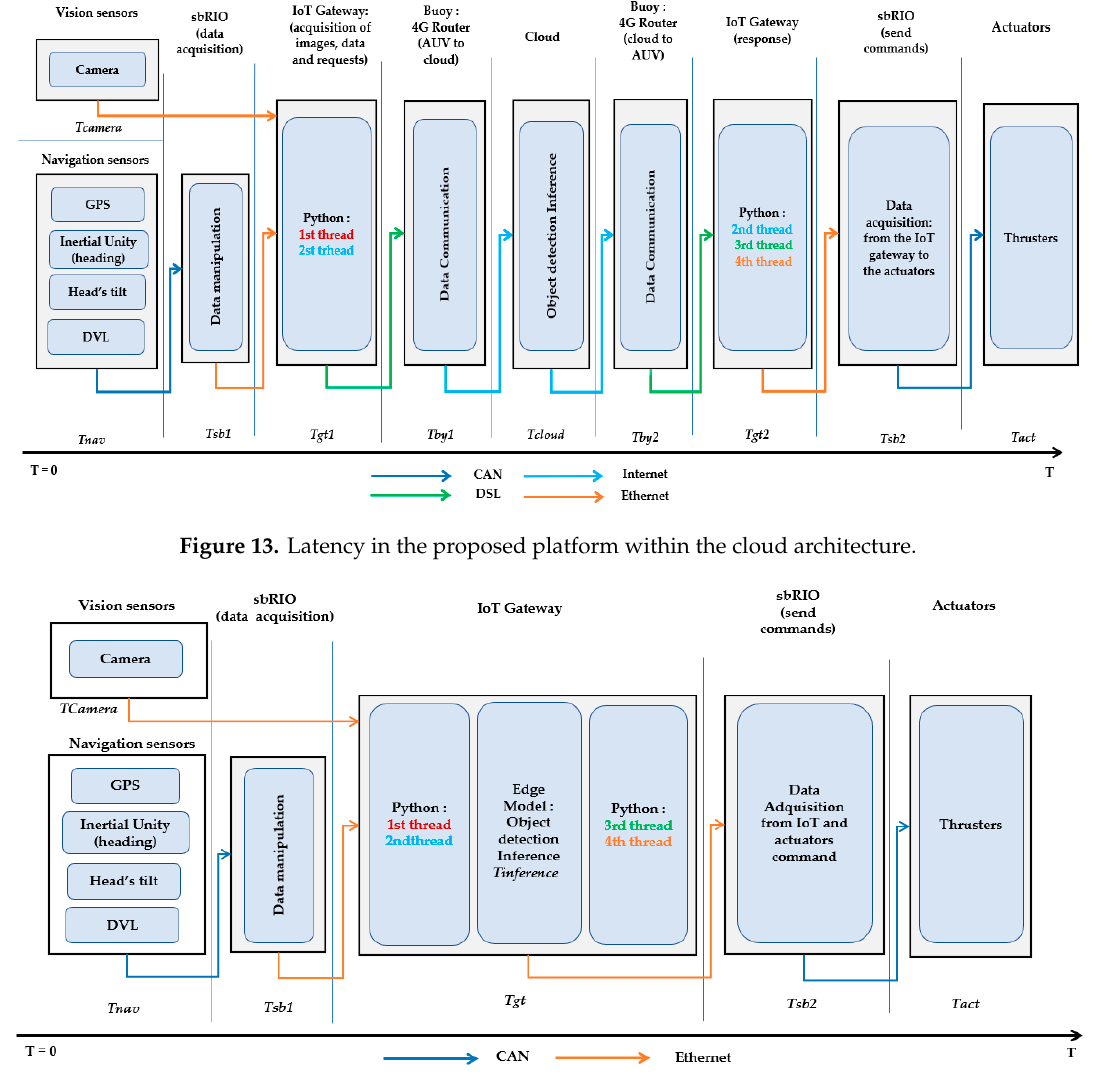
Figure 14. Edge architecture latency in the proposed platform.